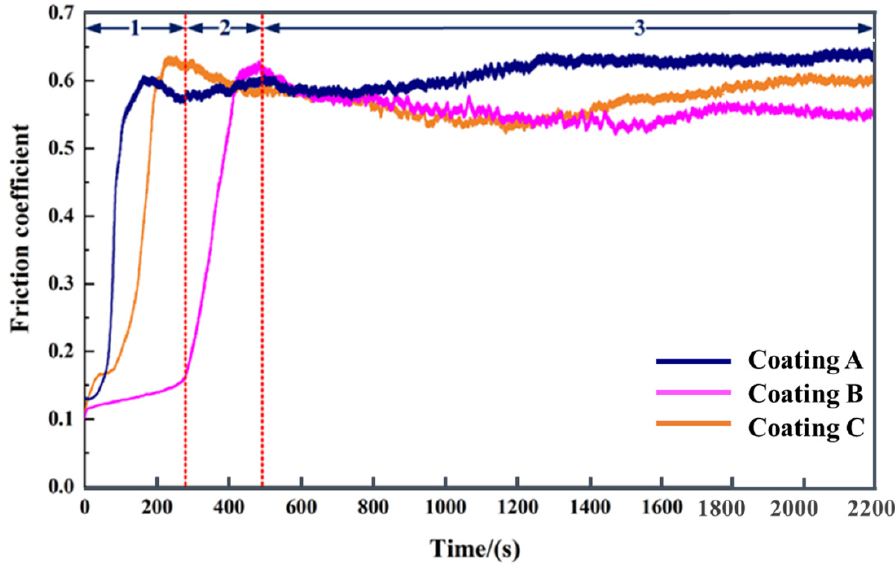
Figure 9. The friction coefficient of coatings A (0 mT), B (20 mT), and C (40 mT) (1: the running-in period, 2: the fast-rising period, 3: the stationary period).